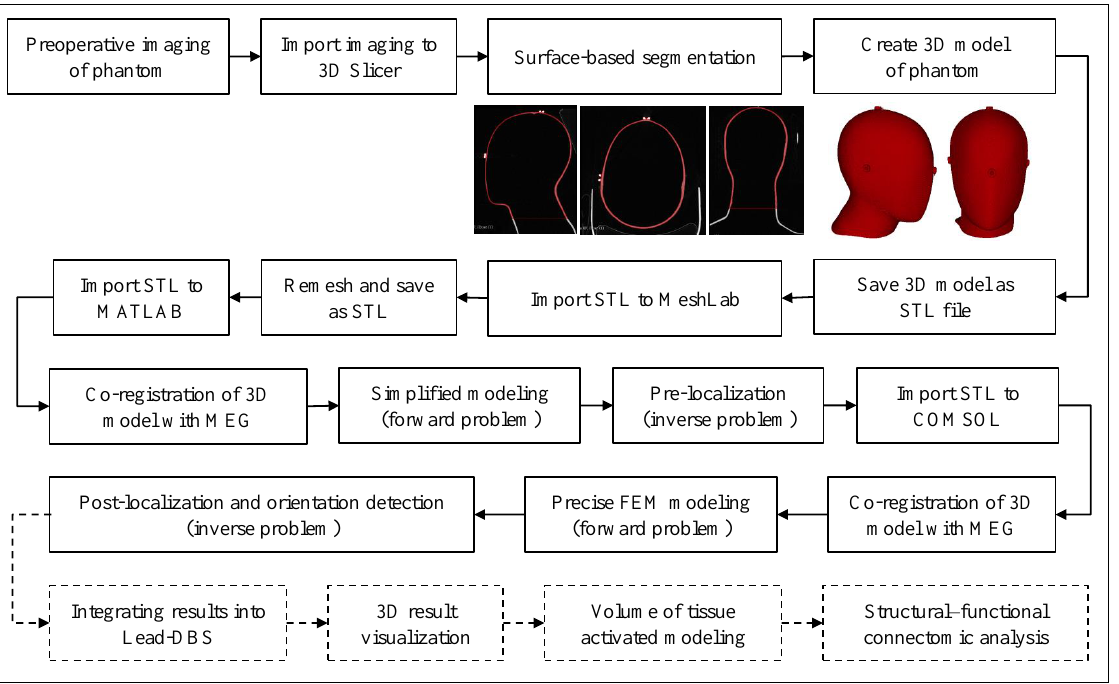
Figure 6. Steps in the modeling process: Preoperative CT is imported into 3D Slicer software, where surface-based segmentation is performed to create the 3D model of the phantom. The model is decimated by remeshing it using MeshLab software. The model is then imported into the appropriate software for